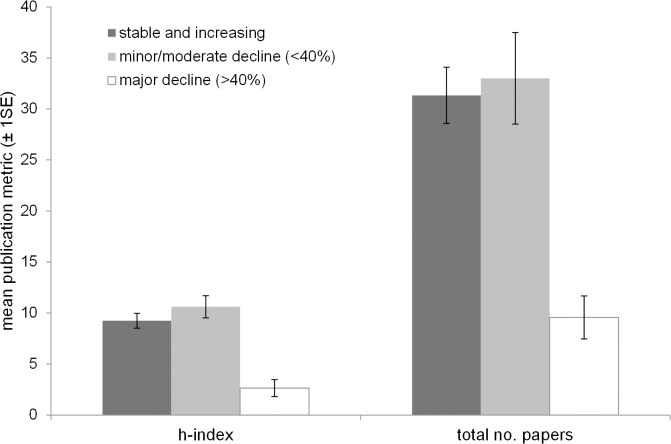
Mean publication metrics (± 1SE) in relation to changing bird distributions over the last 20 years.Species which have undergone severe declines over the past 20 years (>40%) have significantly lower publication metrics than those which have undergone either minor or moderate declines, remained stable or increased (no. papers: Kruskal Wallis χ2 = 14.35, p<0.001; h index: χ2 = 13.67, p<0.001).